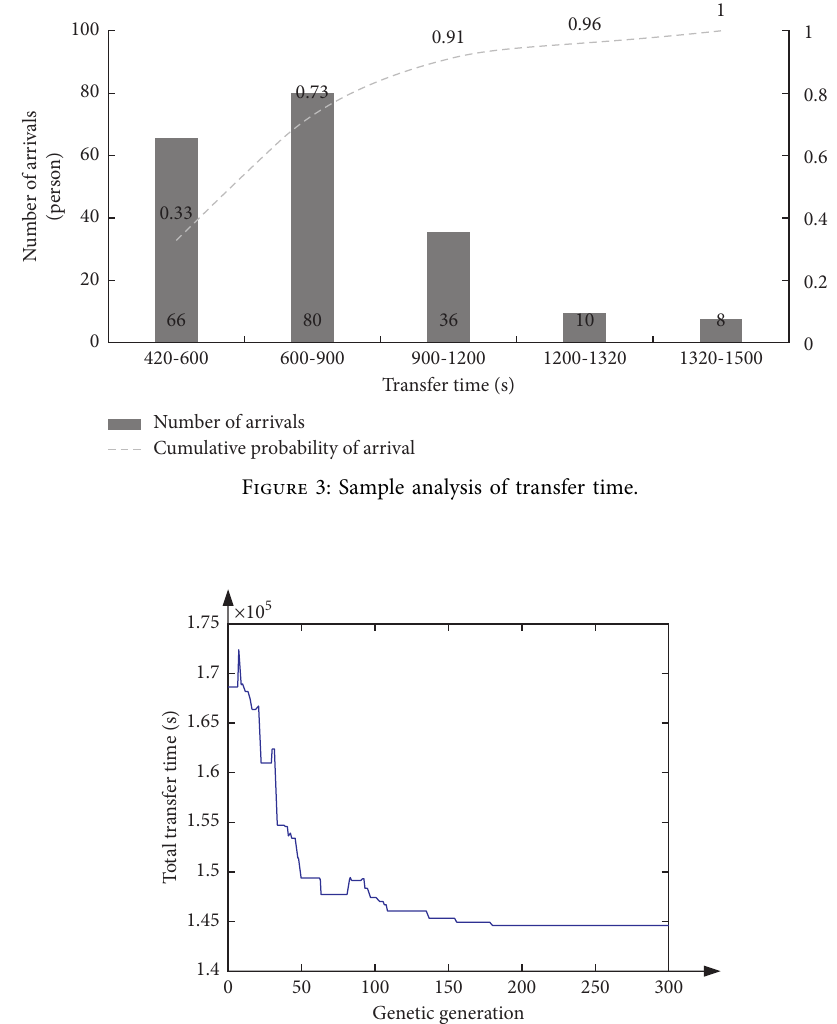
Figure 4: Schematic diagram of the genetic evolution of total transfer time. Table 3: Long-distance passenger departure time before and after